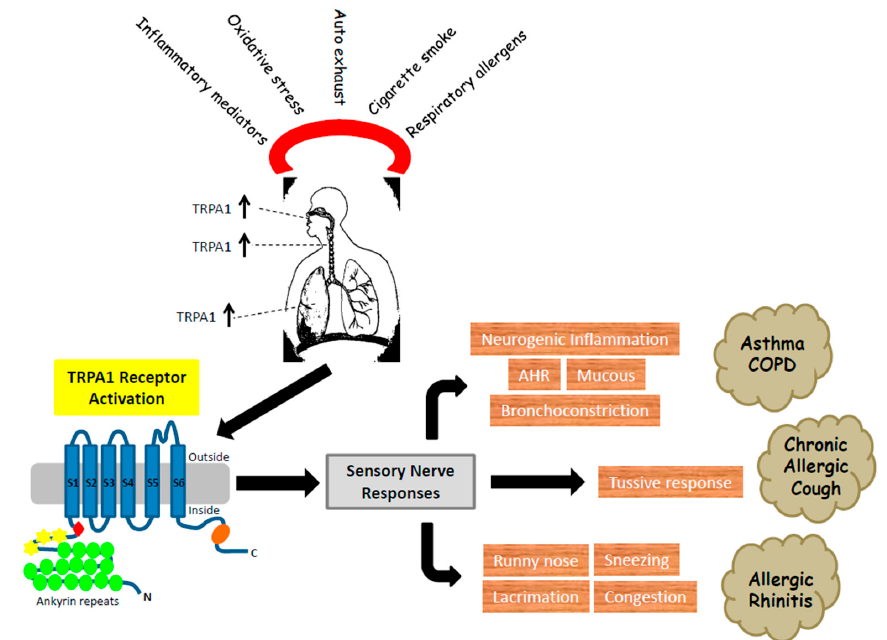
Figure 2. TRPA1 in respiratory diseases.